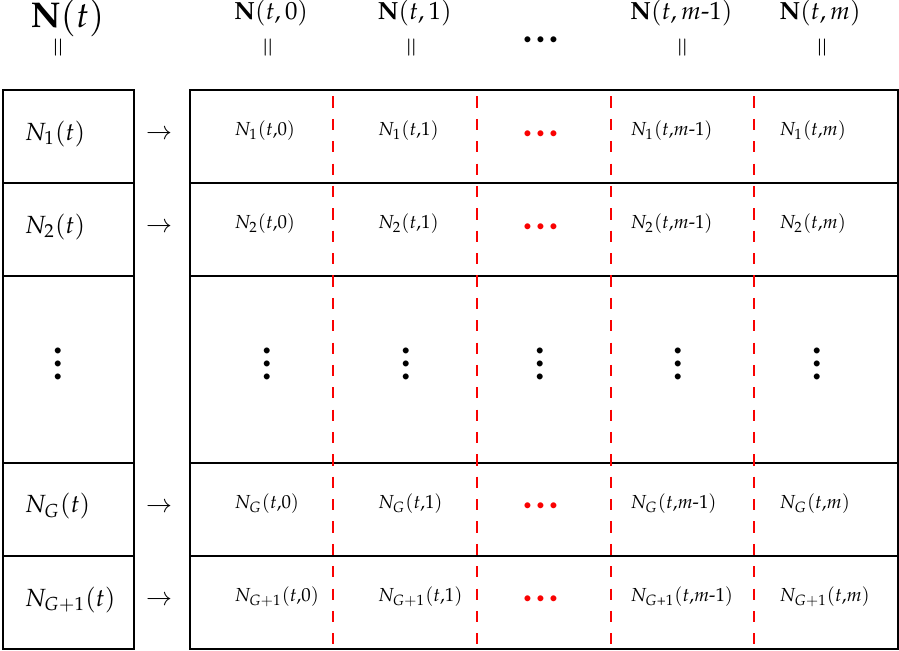
Figure 1. The seniority based stock matrix, consisting of columns N ( t , k )